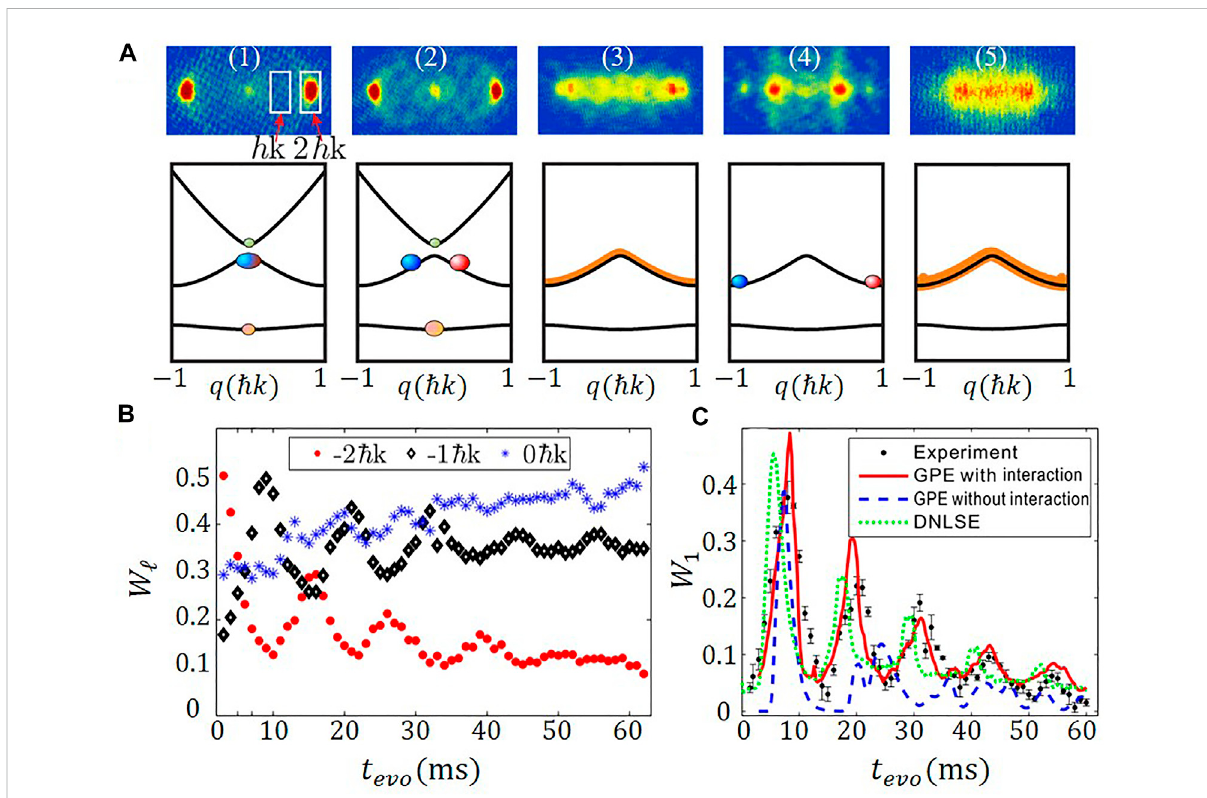
FIGURE 14 (A) Firstrow:themeasuredmomentumdistributionsoftheBECintheP-bandofthe1Dlatticeatdifferentholdingtimes(0 ms,2 ms,5 ms,7 ms, and 30 ms), and the white rectangles are the region for us to calculate the proportion of different momentum states; the second row: schematic illustration of the corresponding population distributions in the Bloch band. (B) Population oscillations around momenta 0 Z k (blue stars), − Z k (black diamonds), and − 2 Z k (red dots) with t > 2 ms. The oscillation period is about 14.9 ms with V = 5 E r . (C) Population for Z k vs. time t evo . The experimentalresultsandtheoreticalsimulationswithandwithouttheinteractioncorrespondtotheblackdotswithanerrorbar,redsolidcurves,and blue dashed curves,